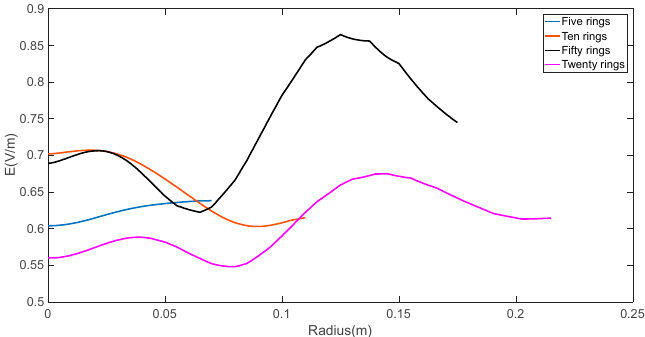
Figure 14. Radial profile of the electric field for a dry poplar sample with a 100% dielectric constant variation between growth rings.